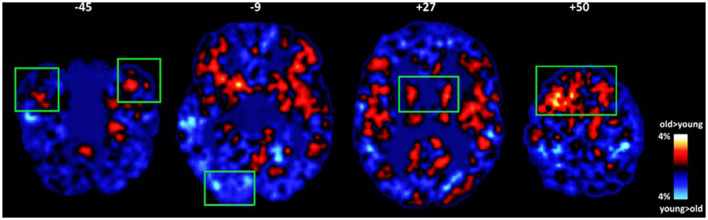
Average maps of voxels where group differences in intrinsic connectivity were found between older and younger adults (old minus young maps of voxels displaying relatively lower ICC). Significant effects of age adjusting for gender, education, and subclinical depression symptomatology are marked by green rectangles (p < 0.01). Older adults displayed higher percentage of voxels characterized by low ICC in the temporal pole, putamen, and prefrontal (medial and dorsolateral) cortices. The opposite trend was found in the inferior occipital gyrus.